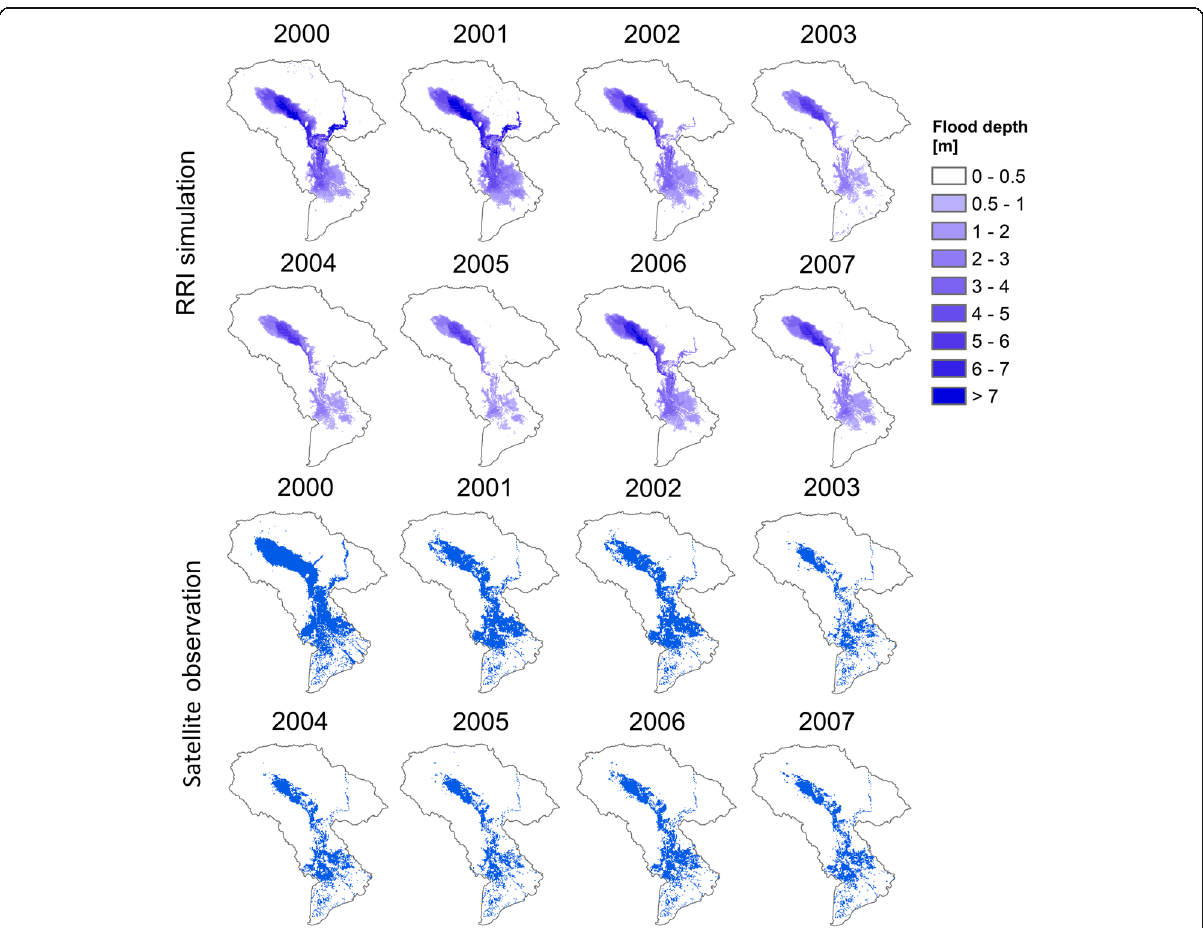
Fig. 3 Comparison of flood extent from simulation result (top) and satellite observation